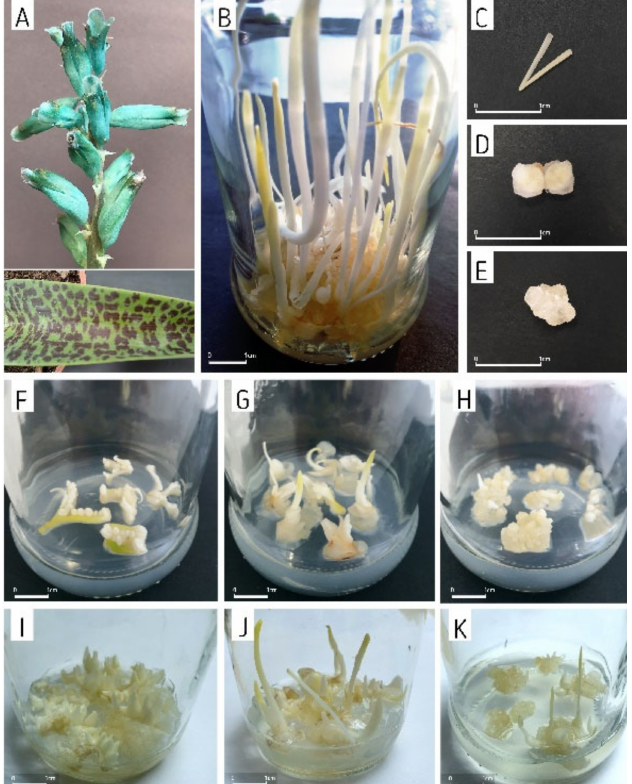
Figure 1. Lachenalia viridiflora : ( A ) Turquoise flowers and spotted leaf; ( B ) The starting culture from which the explants were taken; ( C ) Leaf explant; ( D ) Bulb explant; ( E ) Callus explant. Ad- ventitious bulb formed after: ( F ) 4 weeks of cultivation of leaf explants × S3/5 BA/0.5 NAA; ( G ) 4 weeks of cultivation of bulb explants × S6/2.5 BA/0.5 NAA; ( H ) 4 weeks of cultivation of callus explants × S3/2.5 BA/0.25 NAA; ( I ) 12 weeks of cultivation of leaf explants × S3/2.5 BA/0.25 NAA; ( J ) 12 weeks of cultivation of bulb explants × S3/2.5 BA/0.5 NAA; ( K ) 12 weeks of cultivation of callus explants × S6/without